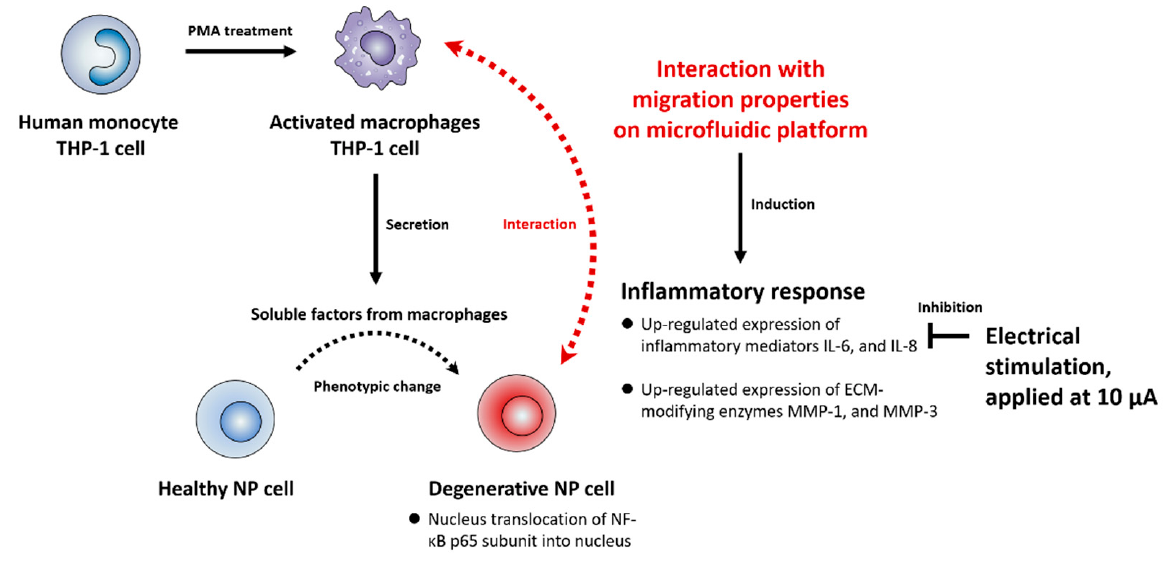
Figure 4. Schematic summary of the interaction between human NP and macrophages in the in vitro model and effects of ES on the degenerative IVD models. In this study, we first confirmed that soluble factors derived from macrophages activate the NF- κ B signaling pathway in human NP cells, inducing the protein production of IL-6, IL-8, MMP-1, and MMP-3 via translocation of NF- κ B p65 protein into the nucleus. Second, we also mimicked a degenerative IVD in vitro model by coculturing human NP cells and macrophages by using a newly developed microfluidic platform. The interactions between the human NP cells and macrophages induced inflammatory milieu through the production of inflammatory mediators and ECM-modifying enzymes. Third, ES demonstrated an inhibitory effect of the production of inflammatory mediators IL-6 and IL-8 in human NP cells under these conditions. Cumulatively, these findings can provide therapeutic target molecules for macrophage-mediated inflammation in degenerative